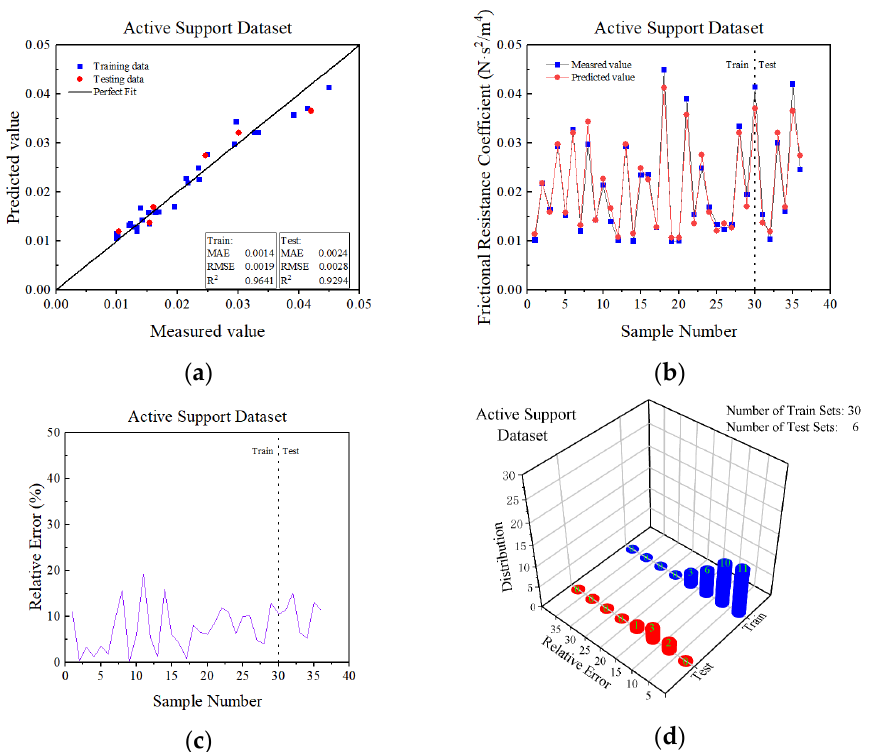
Figure 11. The active support GSCV-RF model prediction results. ( a ) Correlation evaluation of the measured and predicted values of α ; ( b ) curves of the measured and predicted values of the samples; ( c ) sample prediction error curve; ( d ) sample error frequency distribution.